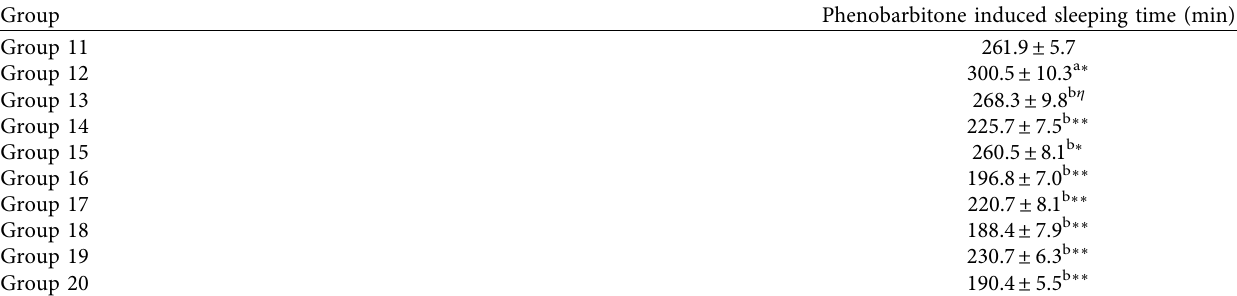
Table 6: Effect of pretreatment with polyherbal formulations on phenobarbitone-induced sleeping time of mice in CCl